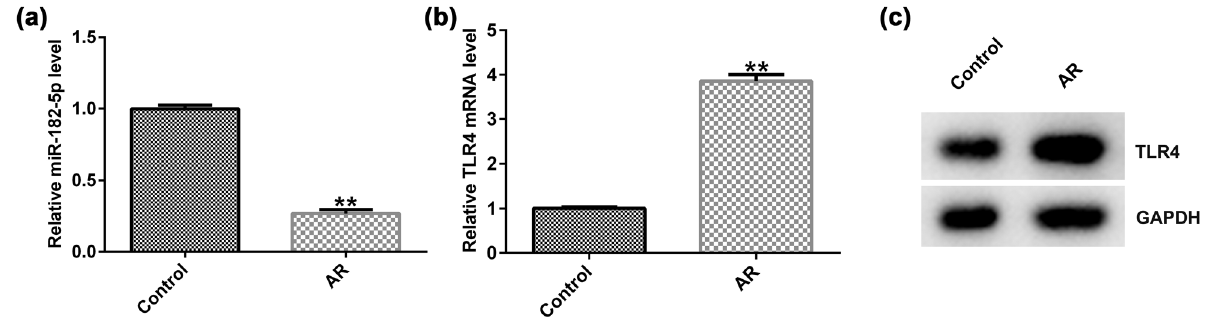
Figure 2: miR - 182 - 5p expression is downregulated and TLR4 is upregulated in AR mice. ( a ) qRT - PCR analysis was used to detect miR - 182 - 5p expression in the untreated and AR groups ( n = 3 ) . ( b ) qRT - PCR analysis was used to detect TLR4 expression in the untreated and AR groups ( n = 3 ) . ( c ) Western blot analysis was used to detect TLR4 protein expression. TLR4, toll - like receptor 4; qRT - PCR, quantitative reverse transcription - PCR.